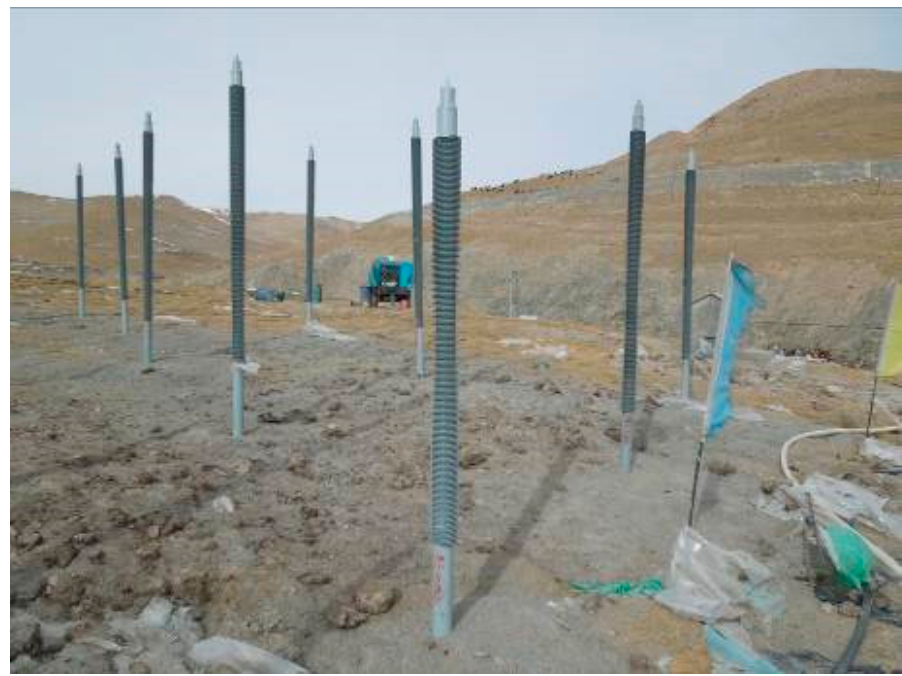
Figure 7. Thermosyphon used in a tunnel located in permafrost regions (Image supplied by G.Q. Zhang).